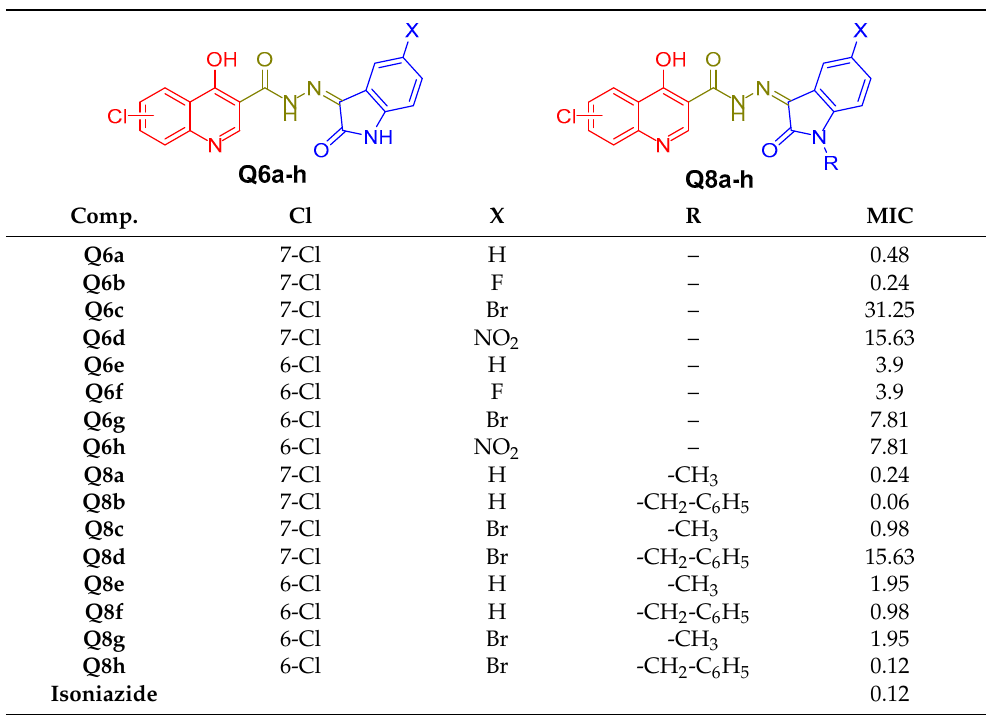
Table 1. Anti-tubercular activity for the synthesized quinolines ( Q6a – h ) and ( Q8a – h ) against M. tuberculosis (MIC).